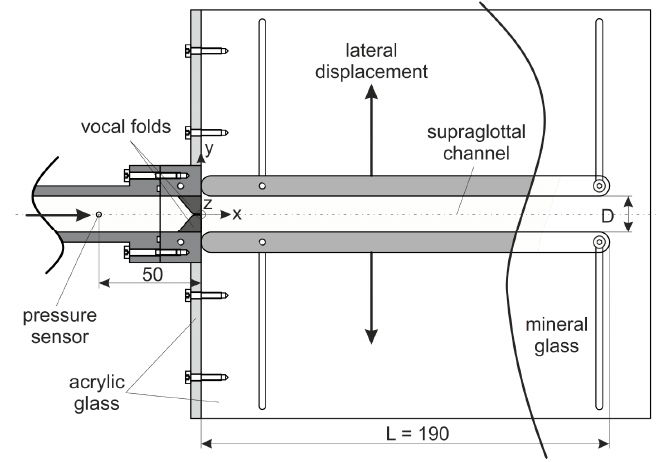
Figure 5. Schematic diagram of the supraglottal channel that allows for the variation of the lateral displacement D (distances are in millimeters).